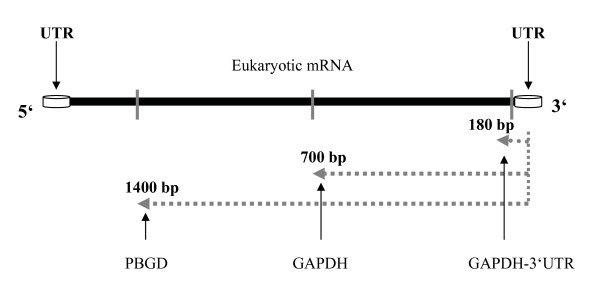
Schematic representation of assessment for RNA intactness. The location of the target sequences (i.e. GAPDH-3' UTR-200 bp, GAPDH-700 bp, and PBGD-1400 bp) on the transcripts.